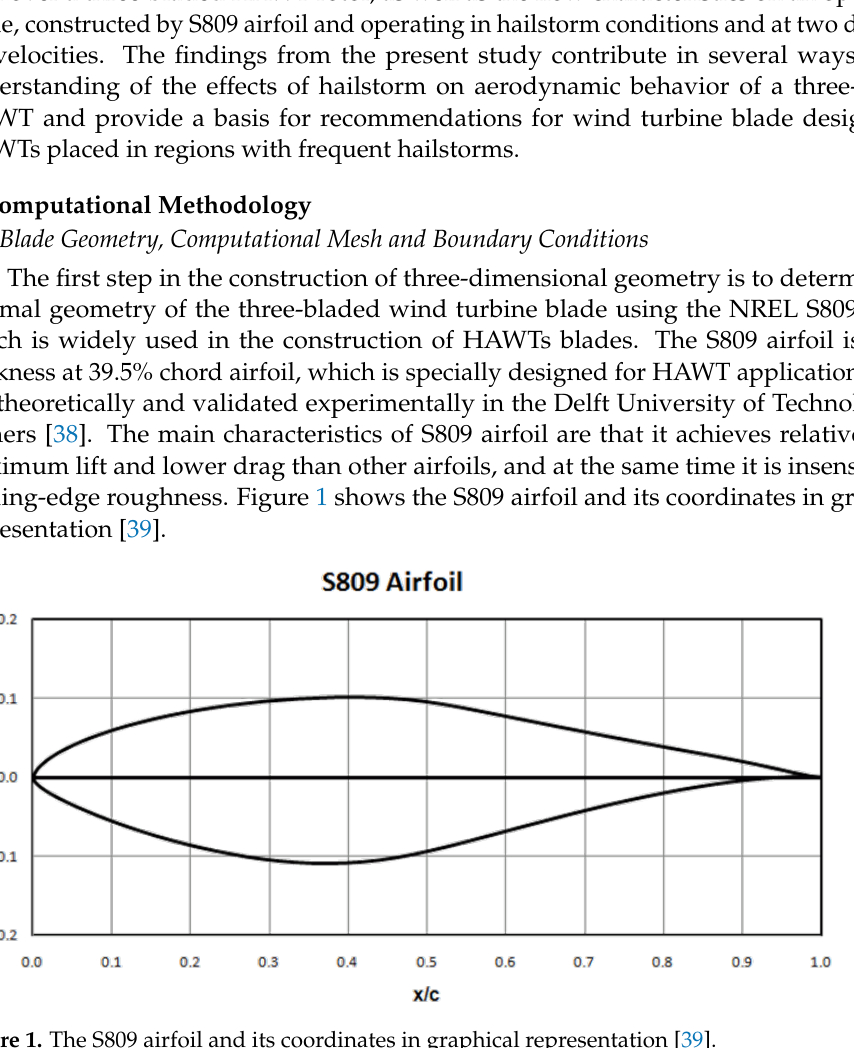
Figure 1. The S809 airfoil and its coordinates in graphical representation [39].